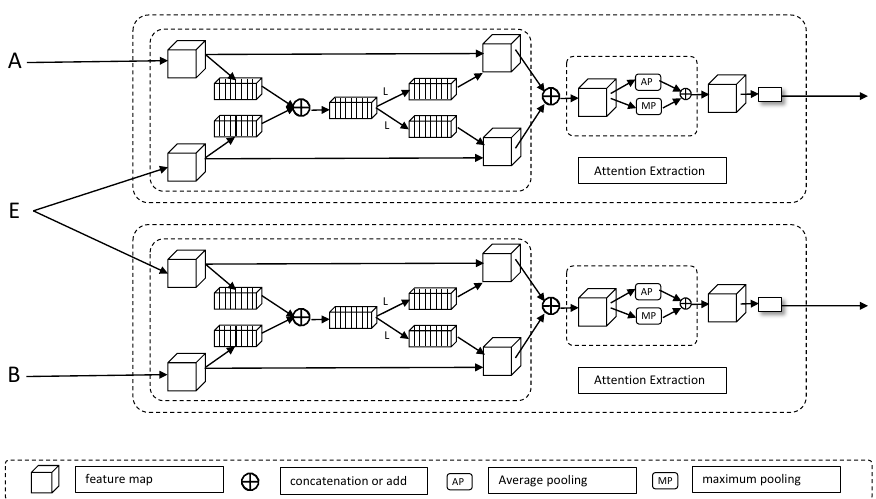
Figure 2. Structure of the AE module. L represents the dense layer. First, the multimodal unified representation is used to obtain the attentions and then applies it to the respective original features, and then the improved pooling operation is used to obtain the output. LiDAR data are fused with hyperspectral data at different scales to obtain more robust